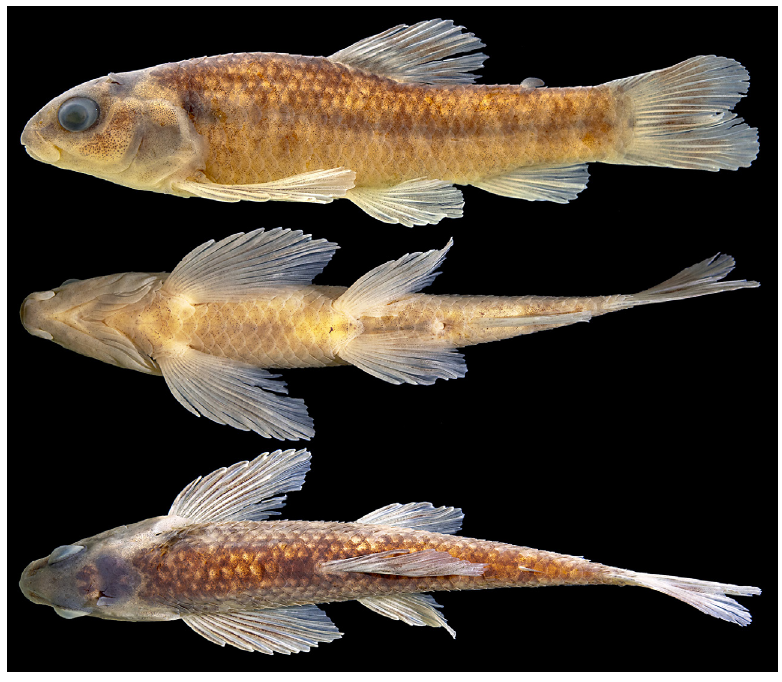
FIGURE 1 | Characidium kalunga in lateral (top), ventral (middle) and dorsal (bottom) views, holotype, MZUSP 125824, 40.5 mm SL, rio Almécegas at Cachoeira de Almécegas, Chapada dos Veadeiros, Alto Paraíso de Goiás,